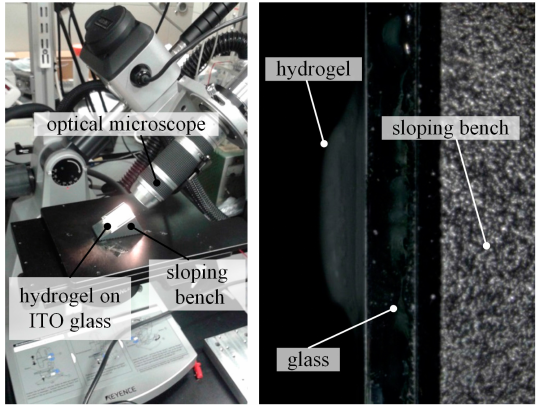
Figure 2. Methods for observing hydrogel’s lateral side. The bottom ITO glass with hydrogel on it is put on a sloping bench, which has a certain tilt angle. Then the optical microscope’s lens are tilted by the sloping bench’s tilt angle. The height of the hydrogel is measured based on the microscopy image.